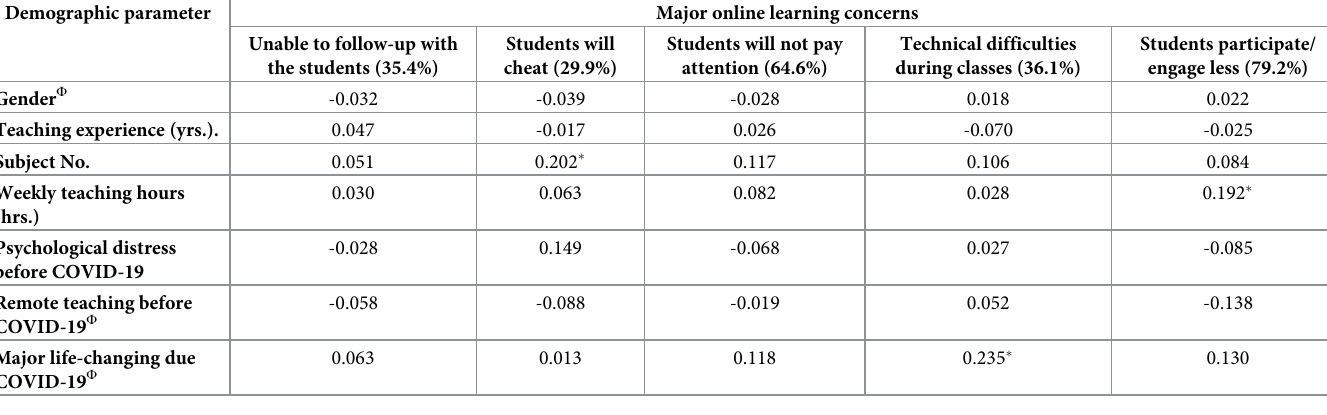
Table 5. Spearman rank order correlations between major online learning concerns and demographic parameters. Demographic